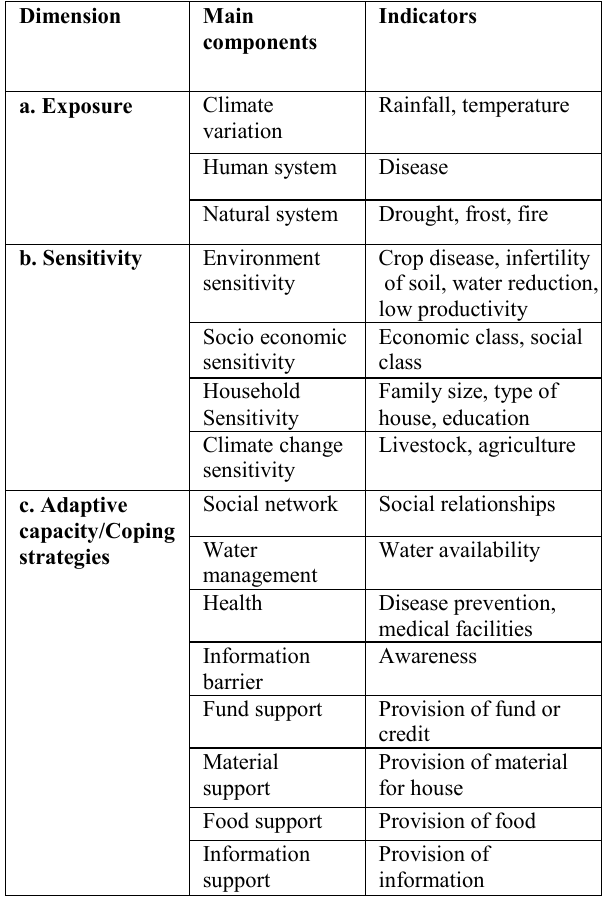
Table 2: Identification of vulnerability indicators Dimension